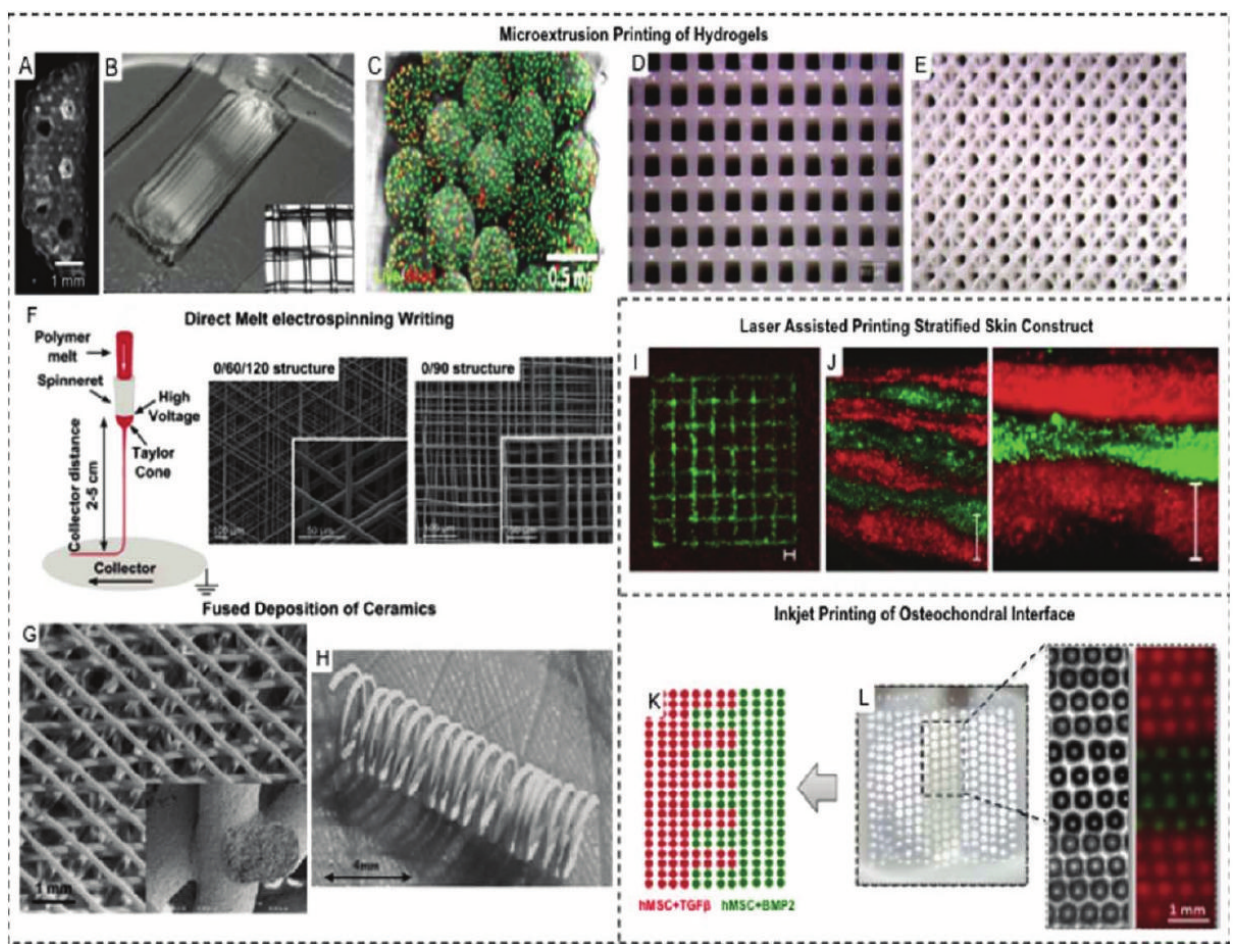
Figure 2: Different 3D printing methods used to manufacture 3D scaffolds for various applications. Courtesy of Obregon et al., 2015